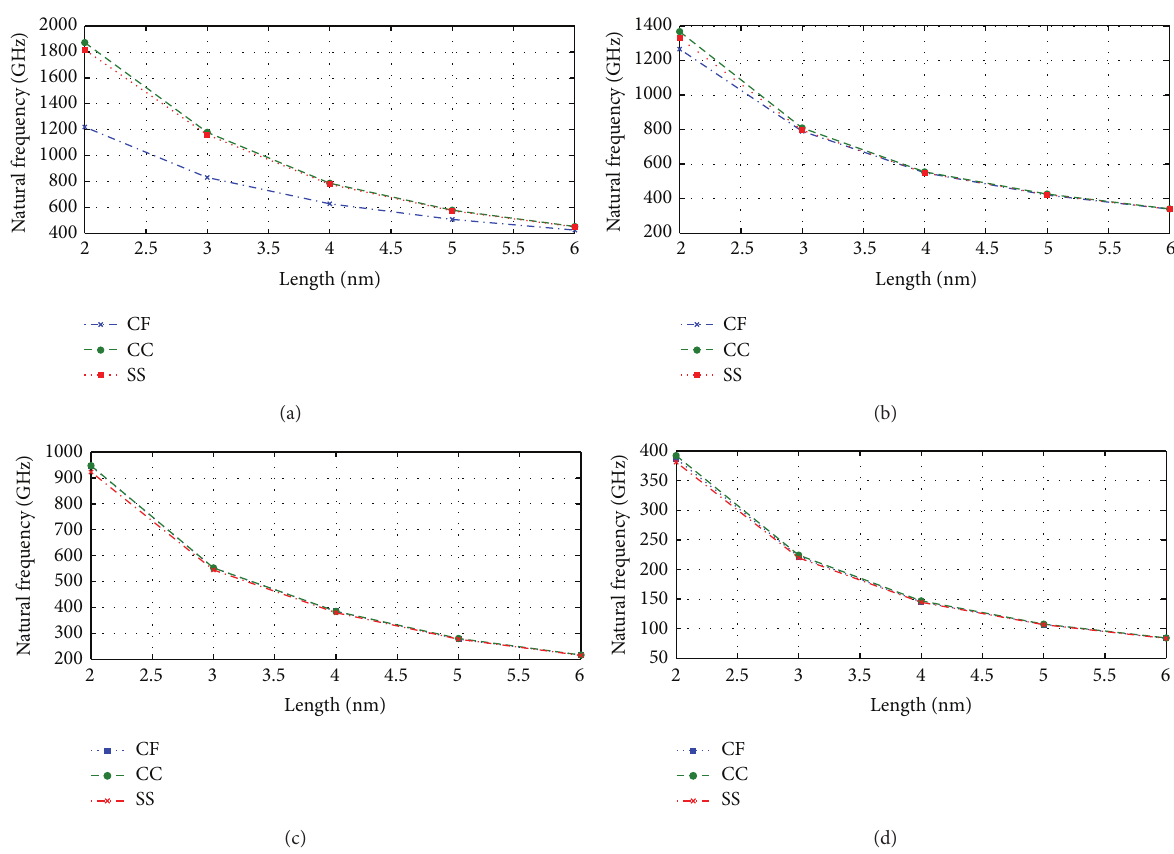
Figure 7: Variation of natural frequencies of the SWCNCs with the length for different apex angles and various boundary conditions: (a) apex angle = 38.9 ∘ , (b) 60 ∘ , (c) 86.6 ∘ , and (d) 123.6 ∘